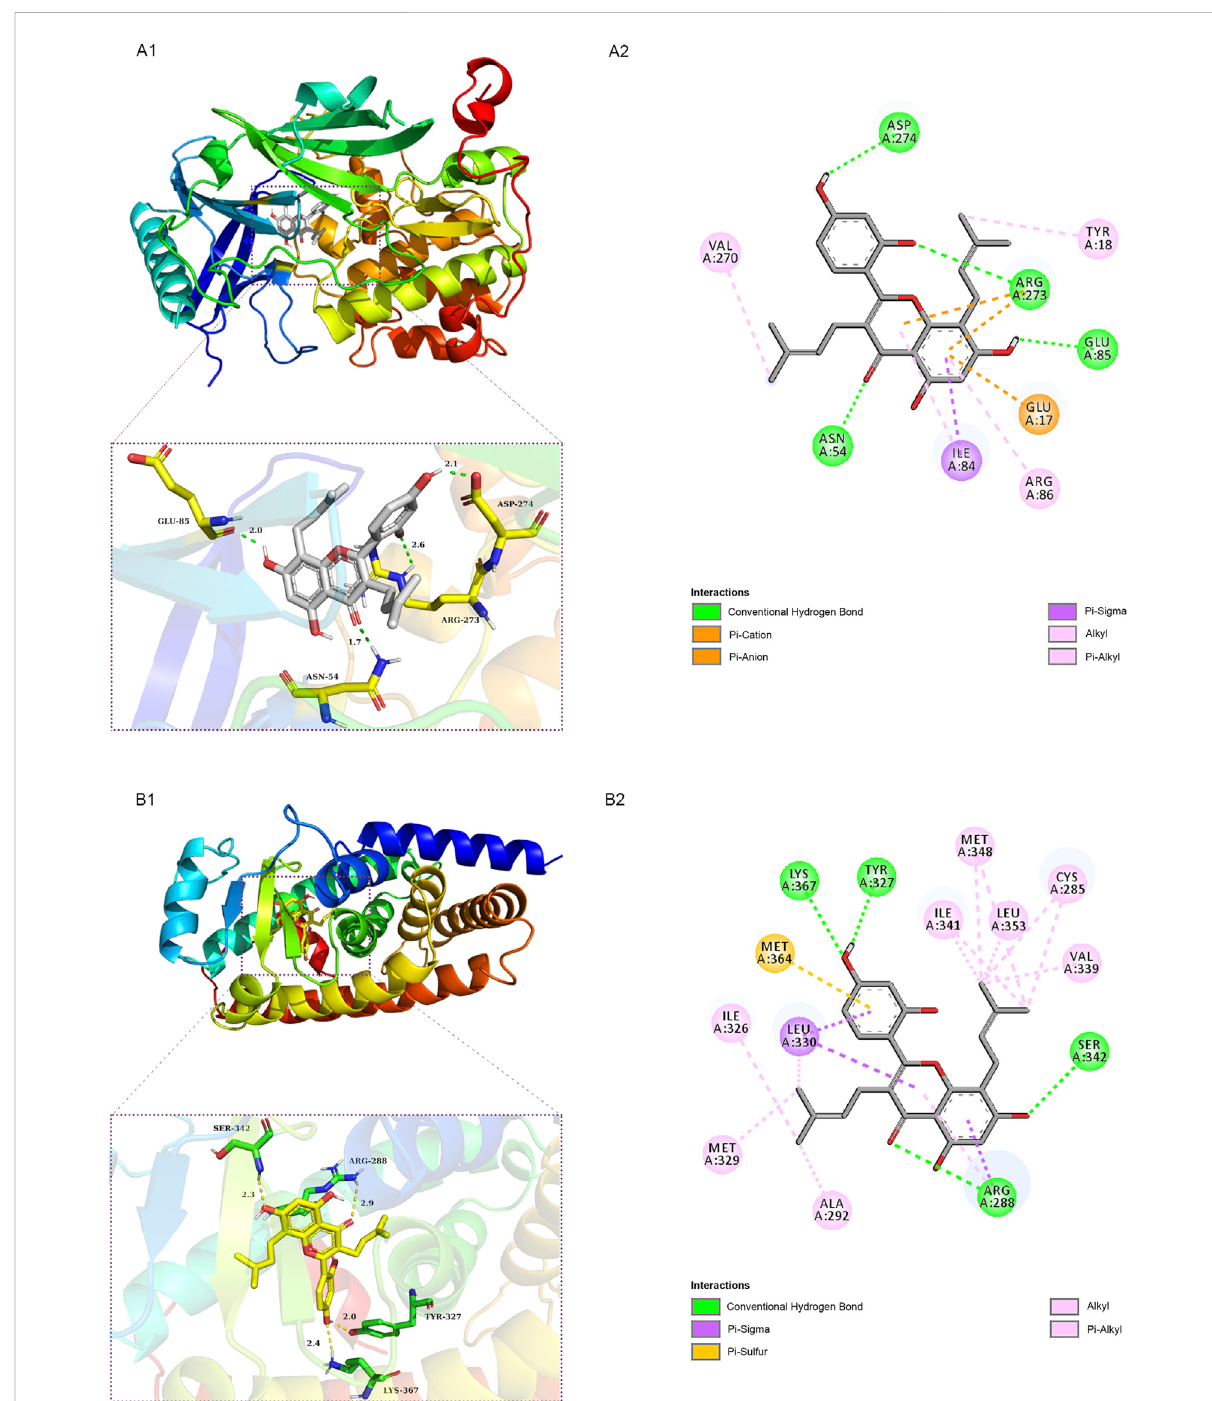
FIGURE 9 Schematic 2D and 3D representations of the molecular docking model and active sites. Binding modes of kuwanon C (MLF24) to AKT1 (A1) , kuwanon C (MLF24) to PPAR γ (B1) , morusyunnansin L (MLF42) to GSK3 β (C1) , and morusin (MLF4) to ADORA1 (D1) . (A2, B2, C2, D2) : Two- dimensional patterns of